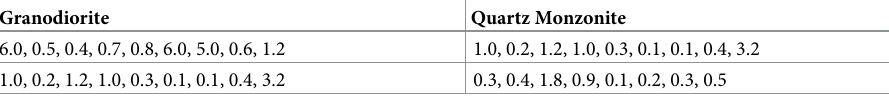
Table 5. Chloride concentration (in mg/litre) in water data. [30].